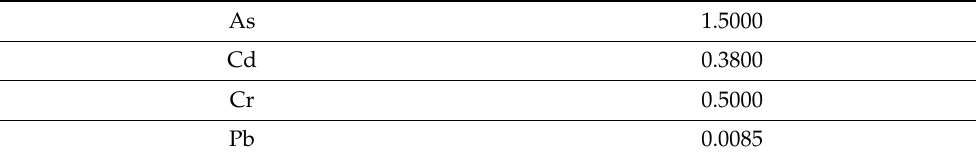
Table 5. CSF to each metallic and metalloid element studied described USEPA’s